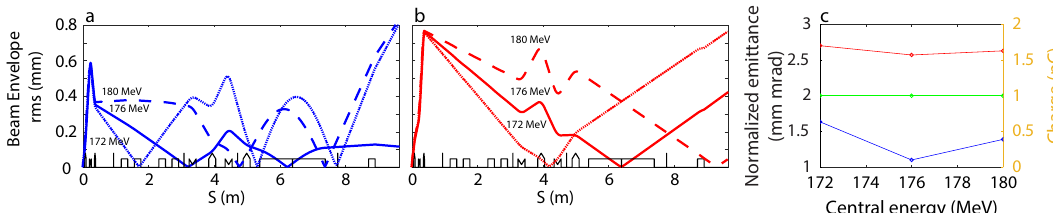
Figure 6. Simulated vertical ( a ) horizontal ( b ) RMS beam envelope along the line. ( c ) Vertical ( blue ) and horizontal ( red ) normalized emittance at the undulator center and total beam charge ( green ). Case of flat-top beams of 180 ± 0.3 MeV ( dashed line ), 176 ± 0.3 MeV ( solid line ), and 172 ± 0.3 MeV = 2 mrad RMS and σ (cid:48) = 3.12 mrad RMS, charge of ( dotted line ), with the “Undulator” optics, an σ (cid:48) z , i x , i 1 pC, (cid:101) x , i , (cid:101) z , i = 0.2